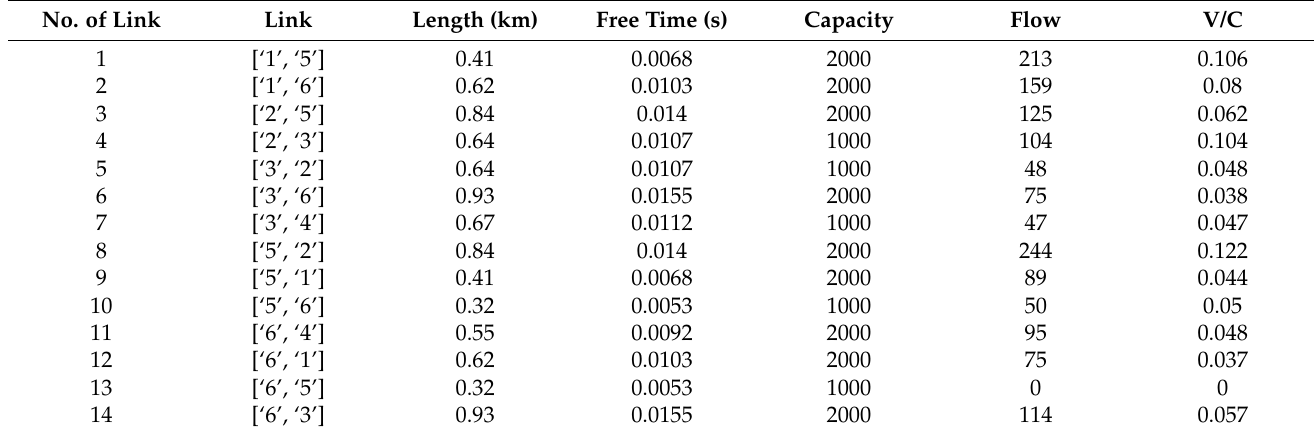
Table 2. Results of link information after traffic assignment.